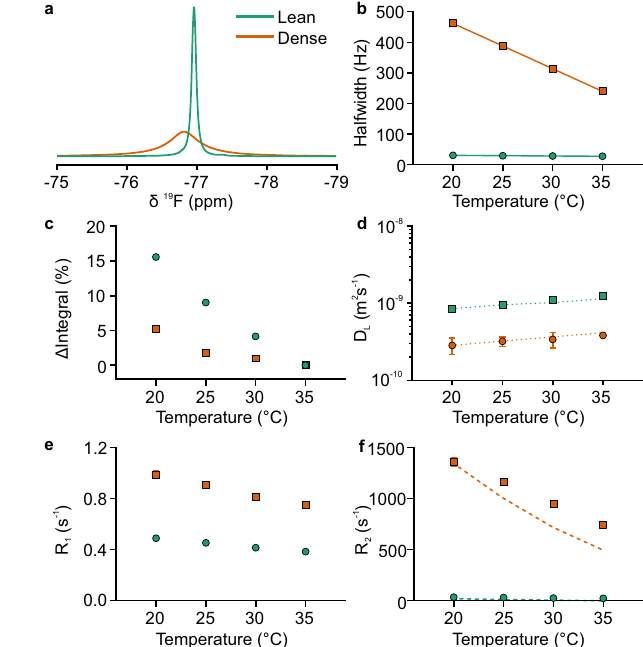
Fig. 2 Analysis of the bulk-detected NMR spectra of isolated BSA lean and dense fractions. a Superimposed 1D 19 F NMR spectra of the two fractions acquired at 35 °C. Behaviour of 1D signal line width ( b ) and signal integral normalised against signal at 35 °C ( c ). d TFE translational diffusion coef fi cients with 95% fi tting con fi dence intervals (estimated using the Monte Carlo approach) as measured by DOSY NMR, with dotted lines indicating expected D L based on temperature-dependent changes in water viscosity (Eq. (7)). TFE longitudinal ( e ) and transverse ( f ) relaxation rates with 95% fi tting con fi dence intervals as a function of temperature. Dashed guidelines indicate expected behaviour given an assumption that relaxation rate is reduced only due to lower water viscosity and faster molecular tumbling at higher temperature (Eq. (5)). For R 1 , R 2 and D L the estimated fi tting errors are generally smaller than the symbols used. Source data are provided as a Source Data fi likely as a result of increased crowding and TFE transiently interacting with BSA. Together these data in isolated fractions show that TFE is dispersed uniformly throughout the two phases, and not con fi ned to the phase boundaries or edges. Although the temperature dependence of molecular diffusion in both dense and (Fig. 2d), R 2 in the dense fraction decreases with temperature slower than expected from viscosity alone (Fig. 2f), suggesting exchange regime.